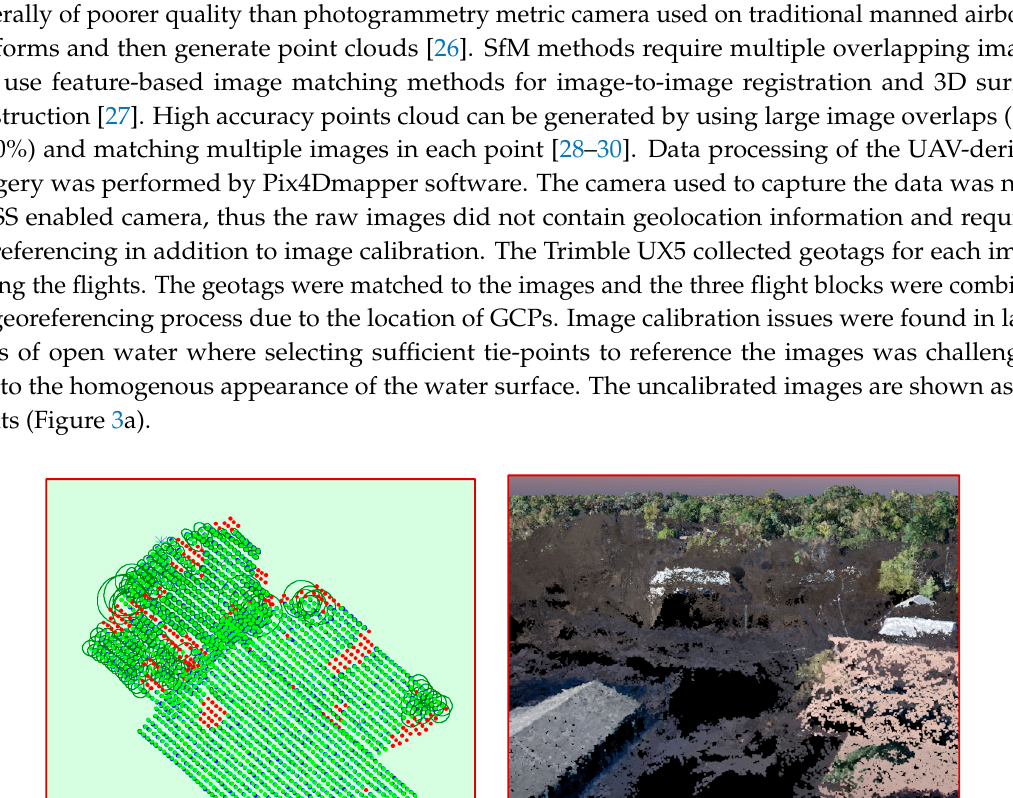
( b ) Figure 4. ( a ) Test area for post-processing and improving the quality of point cloud classification by removing the noises and water artifacts. ( b ) The point cloud after post processing.